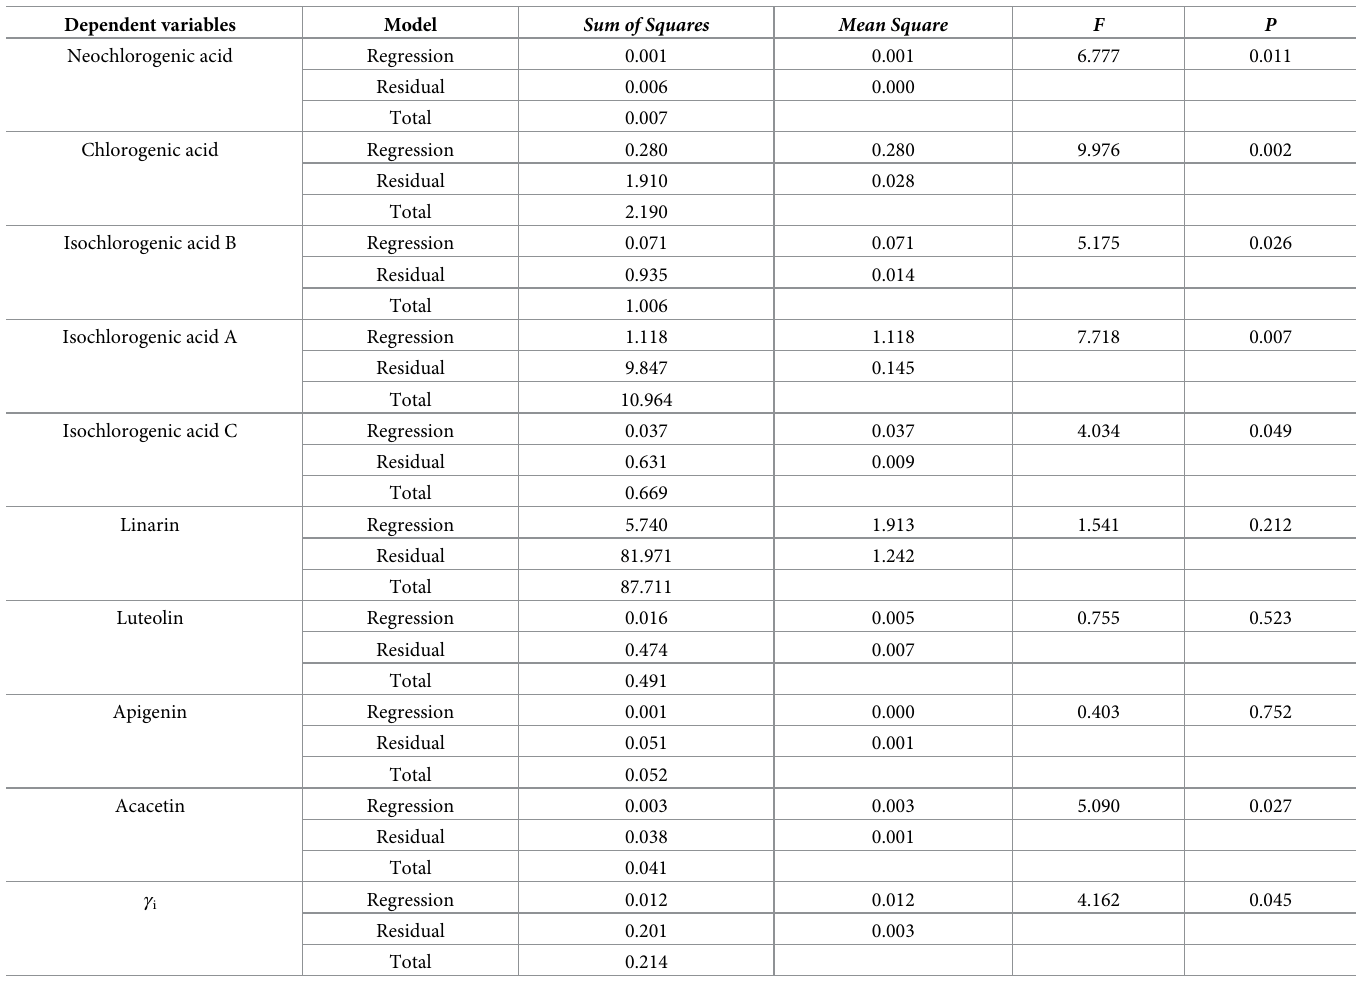
Table 7. ANOVA analysis on the constituents, γ i , and color parameters of